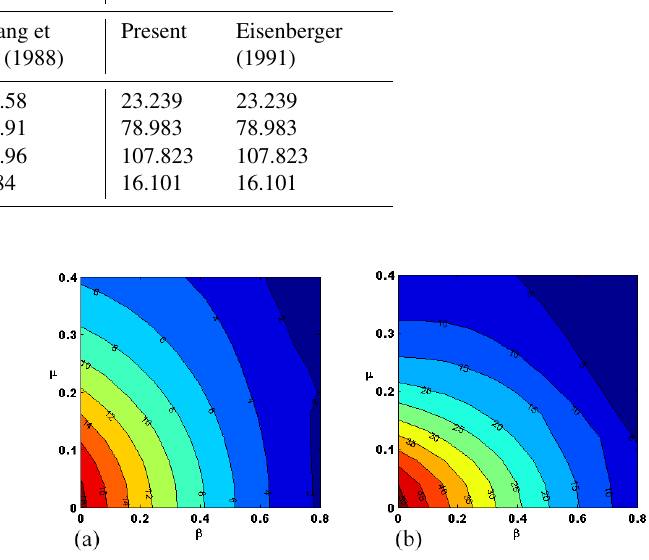
Figure 2. Contour plot of p with respect to β and µ , (a) SS, (b) CS.